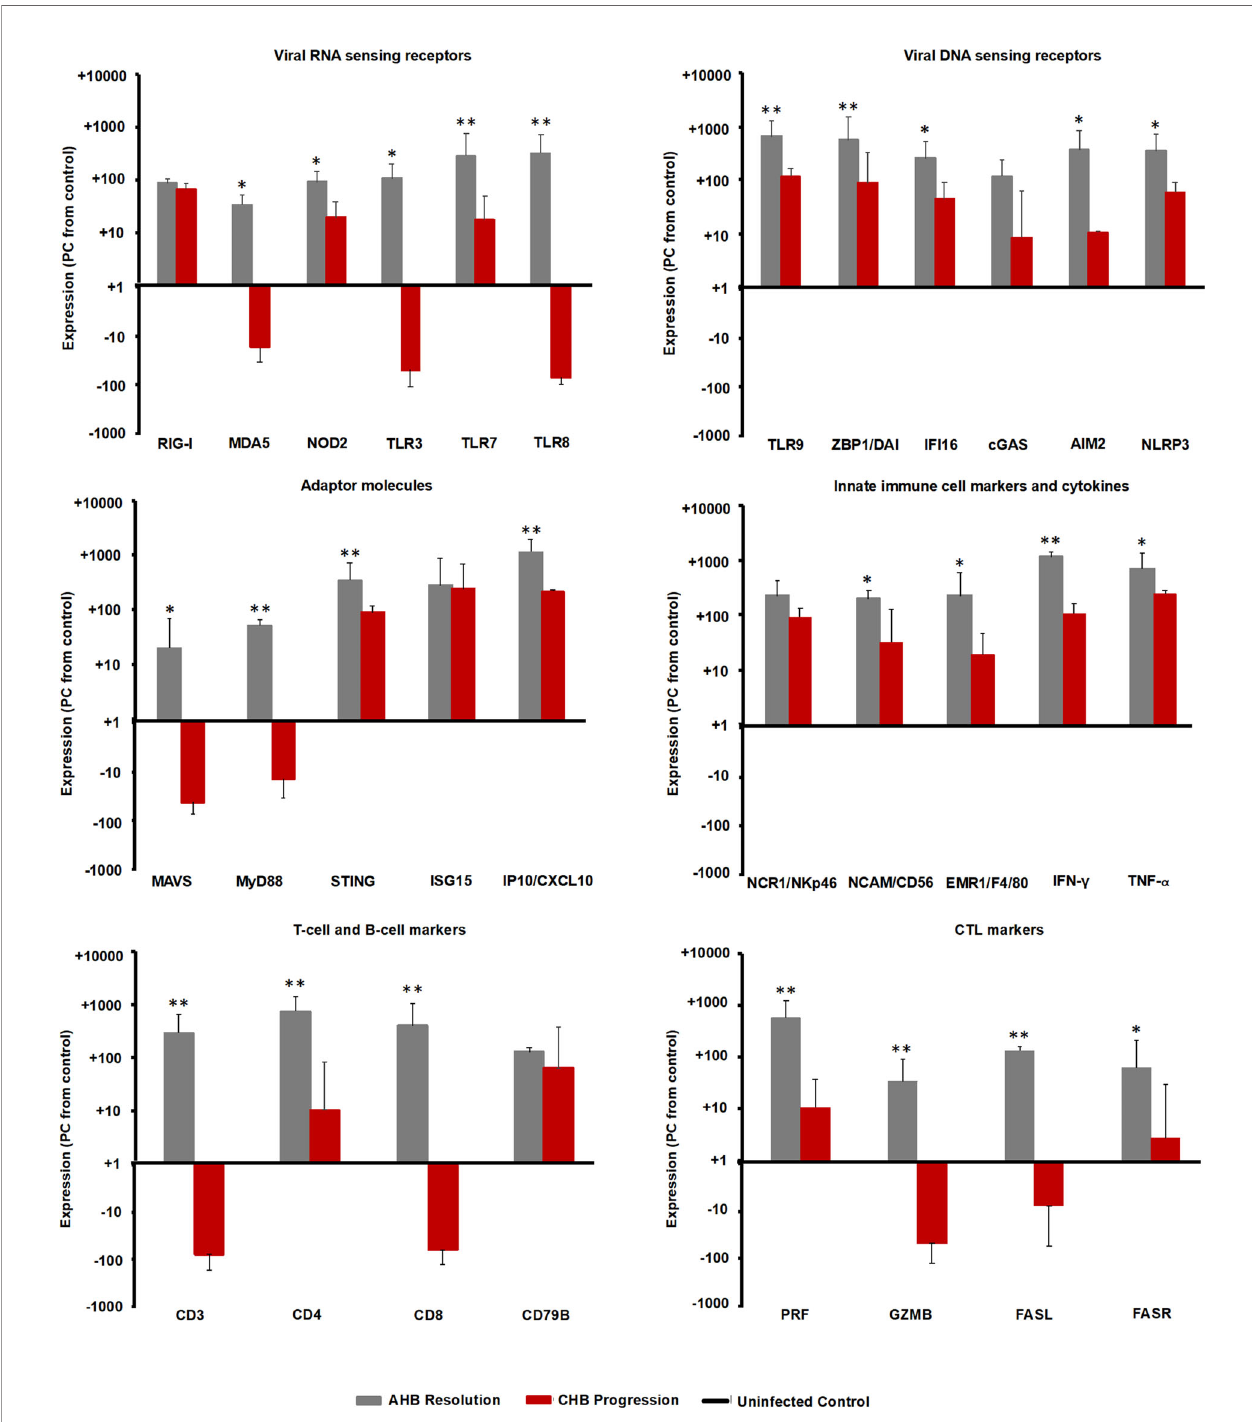
FIGURE 10 | Comparison of intrahepatic expression of PRRs, adaptor molecules, ISGs, innate and adaptive immune cell markers, and cytokines during the resolved and chronic outcomes of WHV infection. Liver expression of important viral RNA and DNA sensing receptors, adaptor molecules, ISGs, innate and adaptive immune cell markers, and cytokines in ten woodchucks each with AHB resolution or CHB progression was compared to their expression in WHV-uninfected controls (i.e., in the liver obtained from the ten woodchucks with normal or delayed AHB resolution prior to WHV inoculation). The marker expression was averaged for each setting (i.e., peak AHB, CHB, and uninfected control). The percentage increase or decrease in expression relative to the uninfected control is presented. Horizontal bars represent the standard error of the mean. P values representing statistical signi fi cance during AHB resolution compared to CHB progression are shown as * for <0.05 and ** for <0.01. PC,